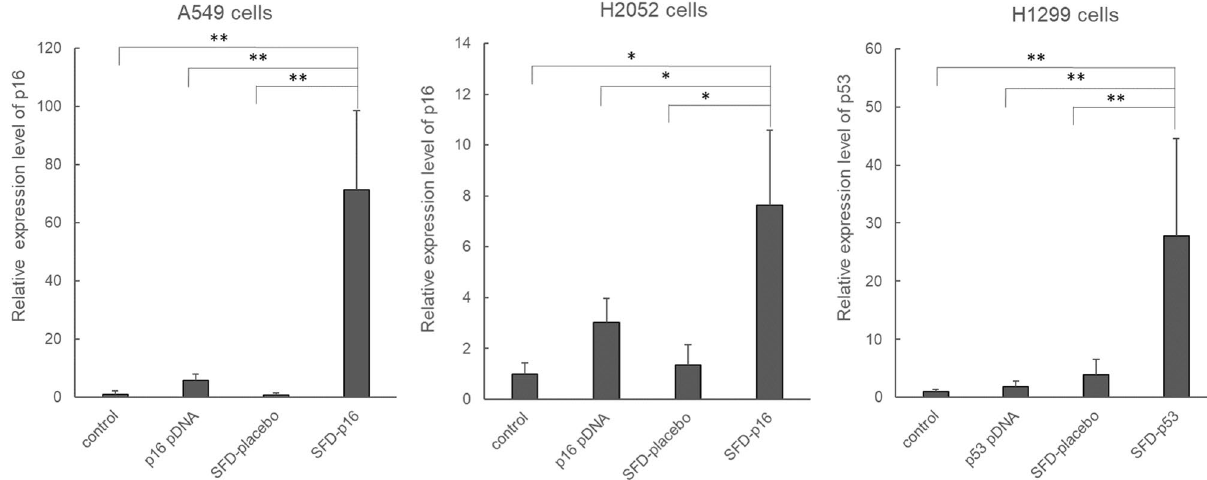
Figure 1. Real-time PCR analysis of gene expression in each cell line 24 h after inhalable gene transfection. In A549 and H2052 cells, the p16 expression of SFD-p16 was significantly higher than that in the control (N = 3). In H1299 cells, the p53 expression of SFD-p53 was significantly higher than that in the control (N = 6–7). The results were analyzed using a one-way ANOVA followed by Bonferroni multiple comparisons tests and Student’s t-test. The data represents the means ± SD (1 = gene expression level of control). ** p < 0.01, * p <